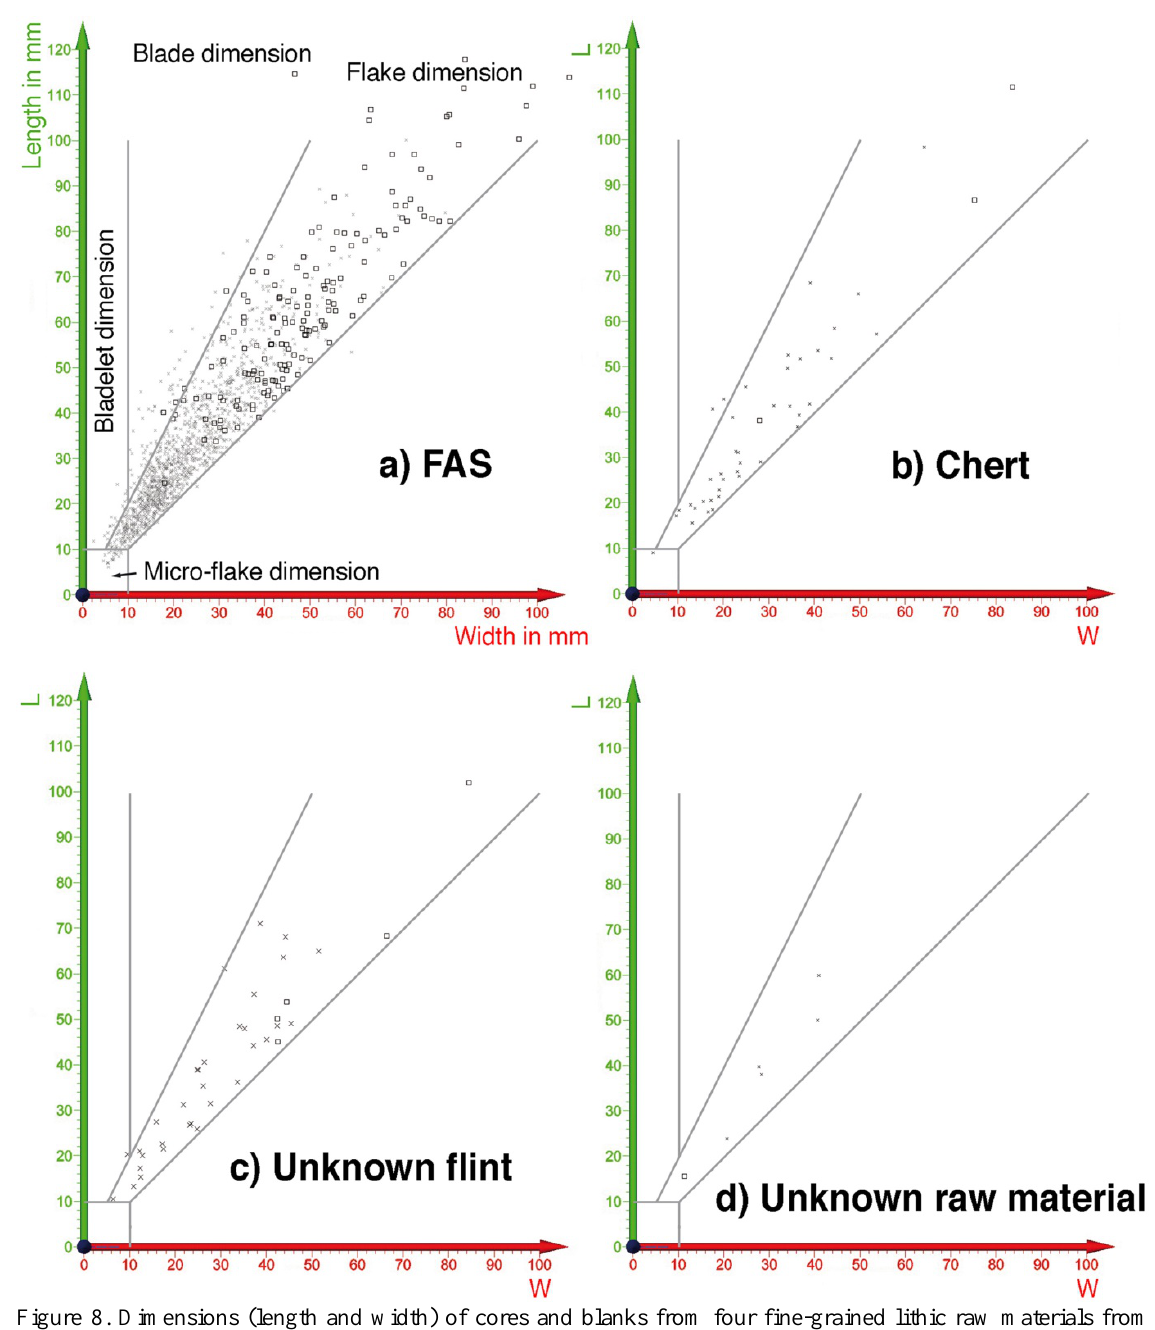
Figure 8. Dimensions (length and width) of cores and blanks from four fine-grained lithic raw materials from GH 3. Cores are displayed as squares and blanks are displayed as crosses. Only dimensions of objects are displayed that are smaller than 120 by 100 mm. a) FAS, b) Chert, c) Unknown flint and d) Unknown siliceous raw